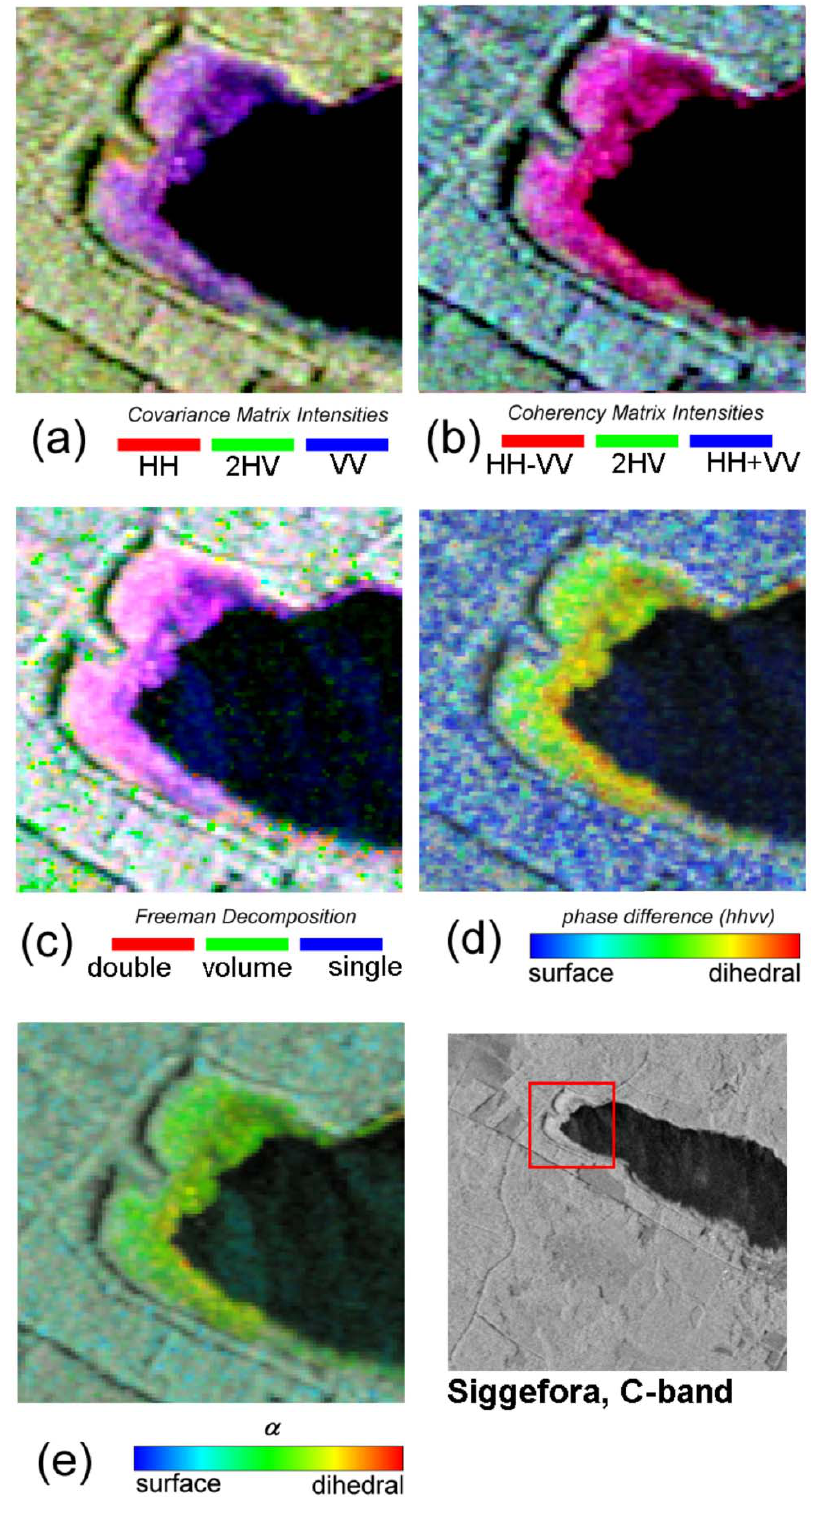
Figure 5. ( a–d ) RGB visualizations of the same C-band data as in Figure 4 but using typical visualizations used for polarimetric imagery. Plate ( e ) is not an RGB composite but is a Hue-Saturation-Intensity image using the α -H decomposition composed of alpha angle for hue, entropy inversely mapped to saturation, and span to intensity. This is similar to how the color of the ellipses are derived in Figure